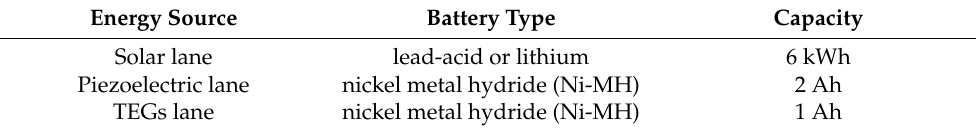
Table 8. Type of batteries.